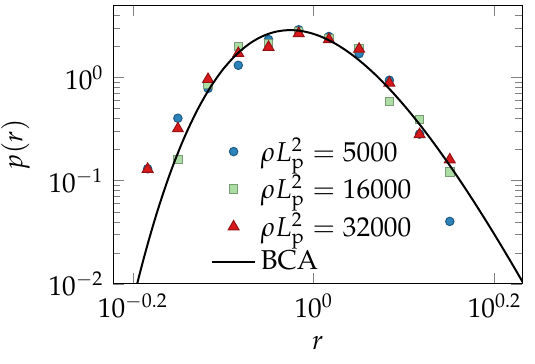
Figure 5. Reduced tube-width distribution obtained from the hybrid Monte-Carlo/Brownian- dynamics computer simulations [51–53]. As expected from the BCA prediction, data for various polymer length concentrations ρ collapse onto a single master